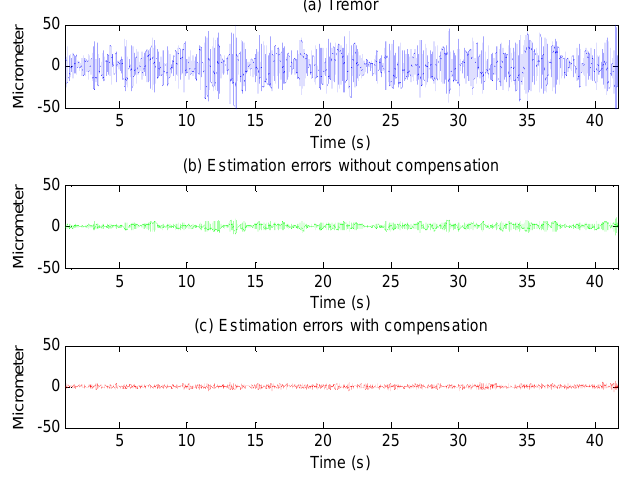
Figure 15. Physiological tremor of a subject ( a ), and estimation errors without compensation for the simulated hardware filter ( b ) and with compensation ( c ).